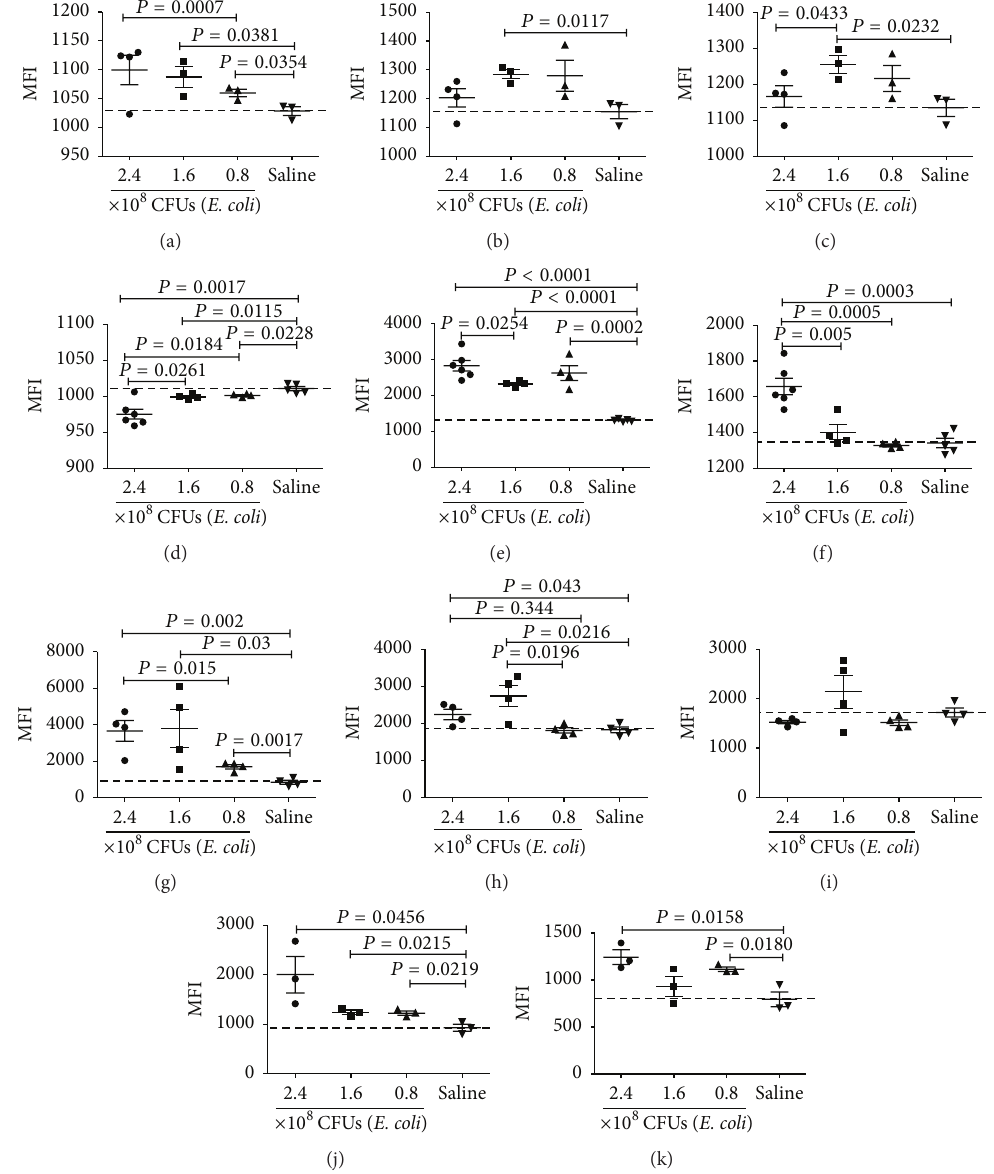
Figure 6: The expression of IL-17 and sTLR9 in/on PMNs, macrophages, and T cells in the PLCs from mice infected with E. coli intraperitoneally at early stage after infection. ICR mice which were infected with E. coli at 3 doses or received saline were sacrificed at 8 hours after infection for harvesting their PLCs. The PLCs were stained with fluorescence-labeled mAb of anti-CD45, anti-CD11b, anti-IL- 17, anti-sTLR9, anti-CD3, and anti-Ly6G, followed by detection with flow cytometry. The expression levels of IL-17 and sTLR9 in various cells of the PLCs were indicated by mean fluorescence intensity (MFI). (a) IL-17 in CD11b − PMNs. (b) IL-17 in CD11b + PMNs. (c) IL-17 in macrophages. (d) sTLR9 on CD11b − PMNs. (e) sTLR9 on CD11b + PMNs. (f) sTLR9 on macrophages. (g) sTLR9 on CD11b + Ly6G + PMNs. (h) IL-17 in CD11b + Ly6G + PMNs. (i) IL-17 in sTLR9 + CD11b + Ly6G + PMNs. (j) IL-17 in CD3 + PLCs. (k) IL-17 in CD3 − CD11b + PMNs. Each point represents the data from one